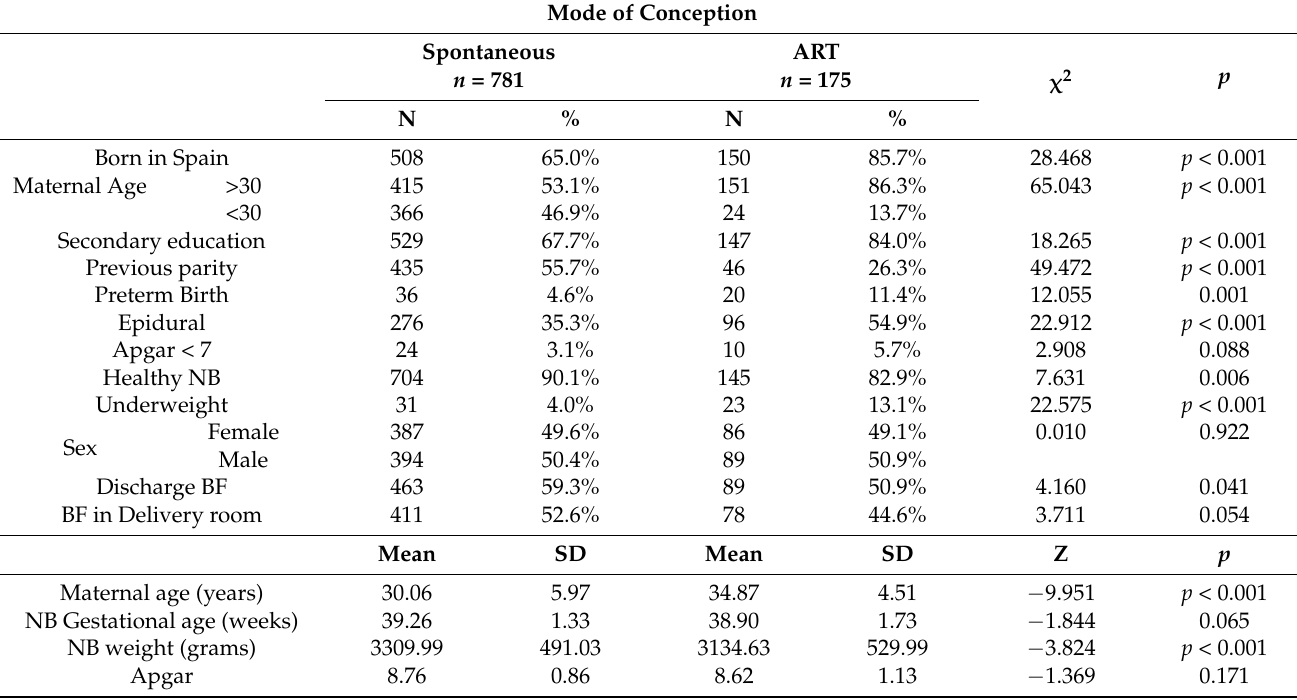
Table 2. Sociodemographic and clinical categorical data in vaginal delivery ( n = 956).